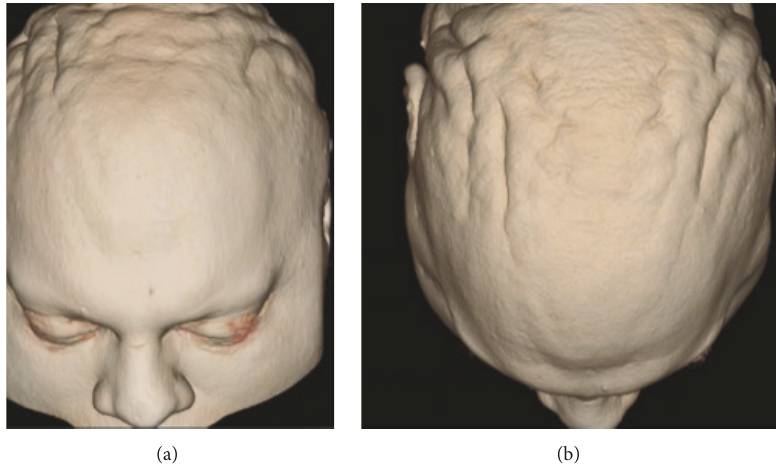
Figure 2: ((a) and (b)) Presence of cutis verticis gyrata proven in this MRI image.